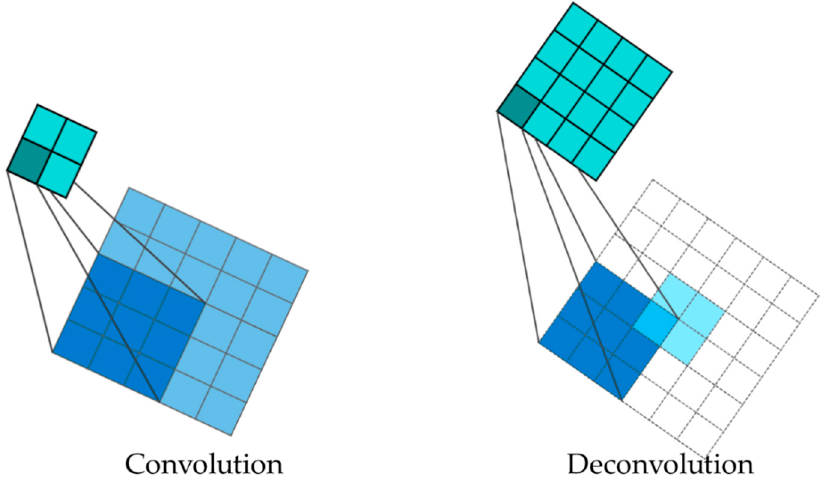
Figure 4. Process of convolution ( left ) and deconvolution ( right ) in proposed FCN.